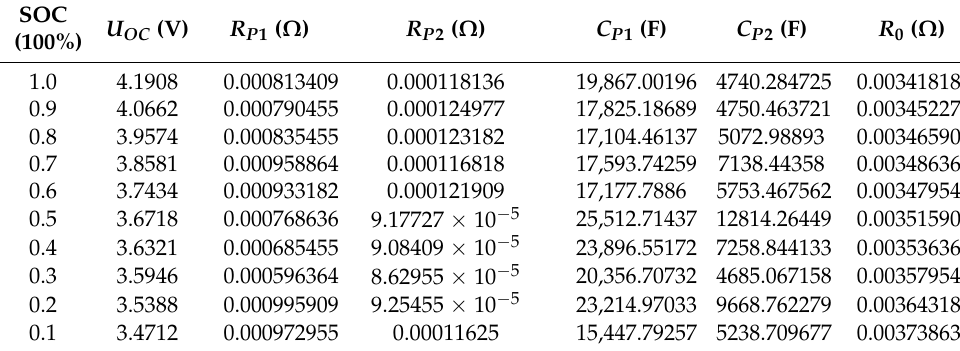
Table 1. Results of the model parameters.